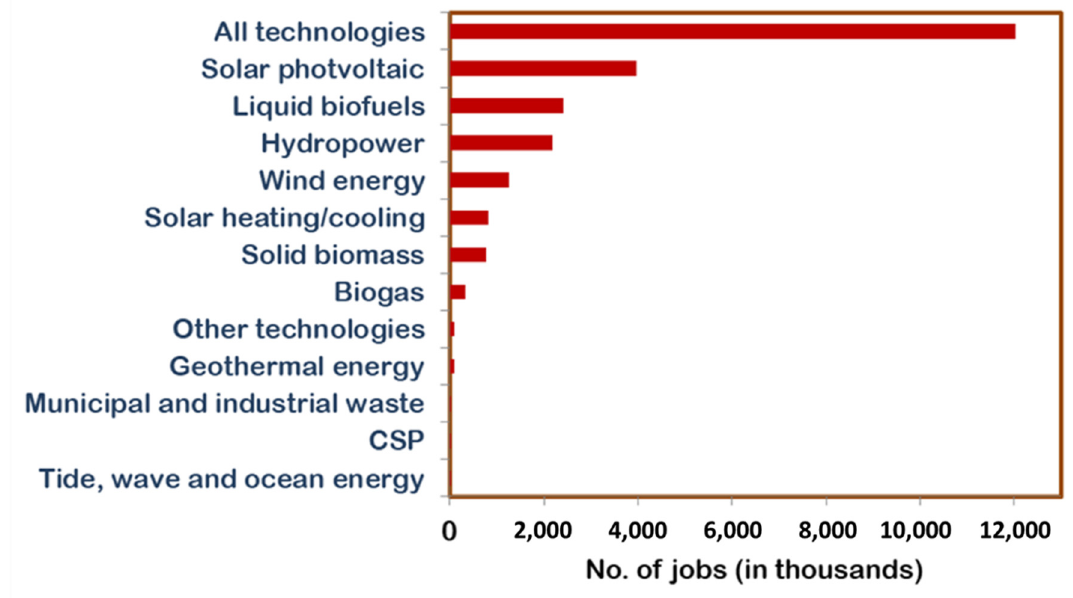
Figure 9. World renewable energy employment numbers [138], open access.